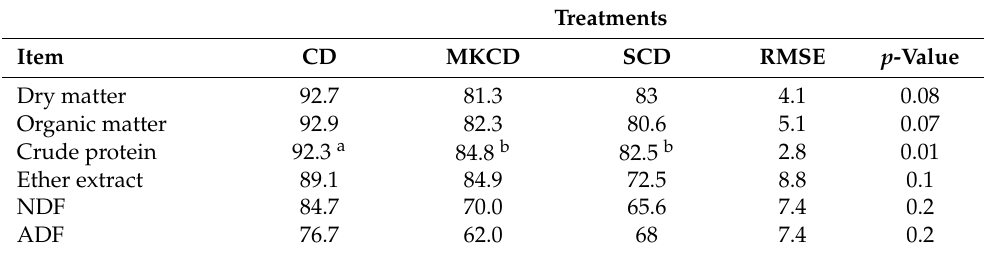
Table 4. Apparent nutrient digestibility (% dry matter basis) by the lambs.